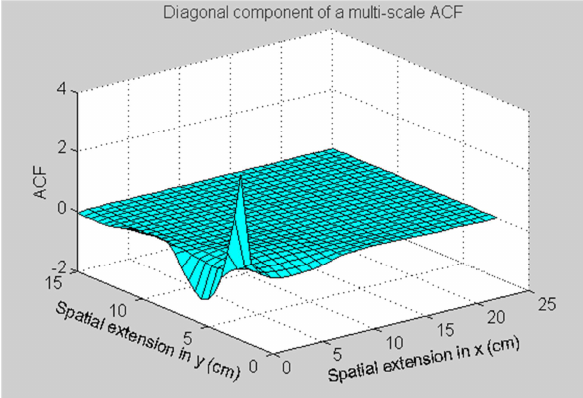
Figure 2. Diagonal component of a MLS two-dimensional